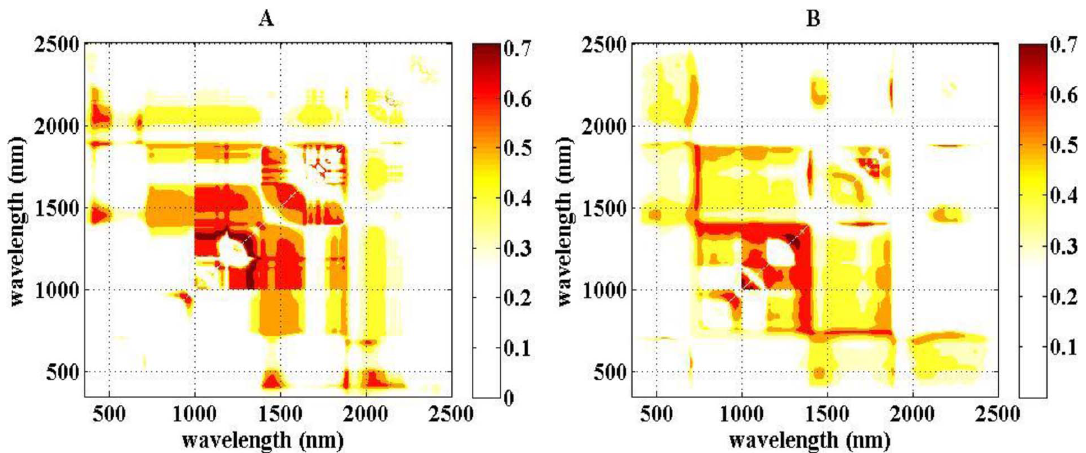
Figure 4. Contour map of coefficients of determination (R 2 ) for linear relationship between NDSI and LEWT (A: calibration dataset, B: validation